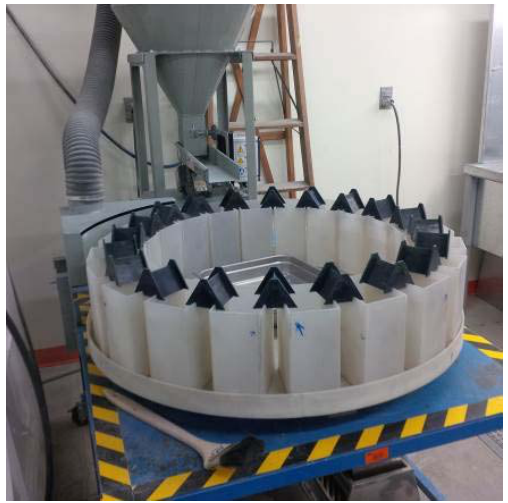
Figure 7. Laboratory rotary sample divider.